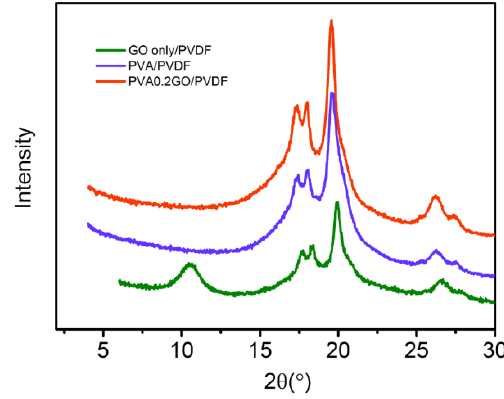
Figure 7. XRD curves of composite membranes.